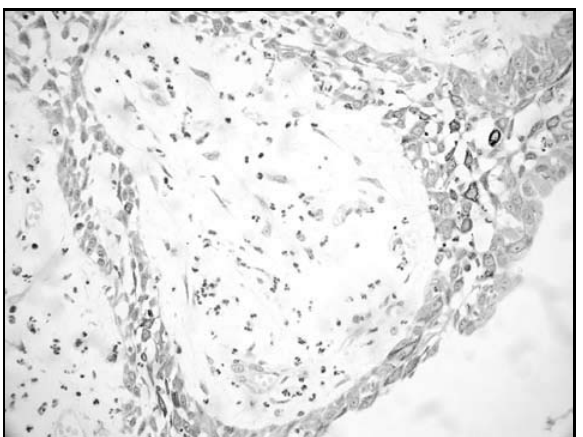
Os tumores que surgem do epitélio odontogênico ou derivados de seus remanescentes exibem comportamento biológico variado, podendo ser benignos e malignos e ainda exibir grande diversidade morfológica (7)